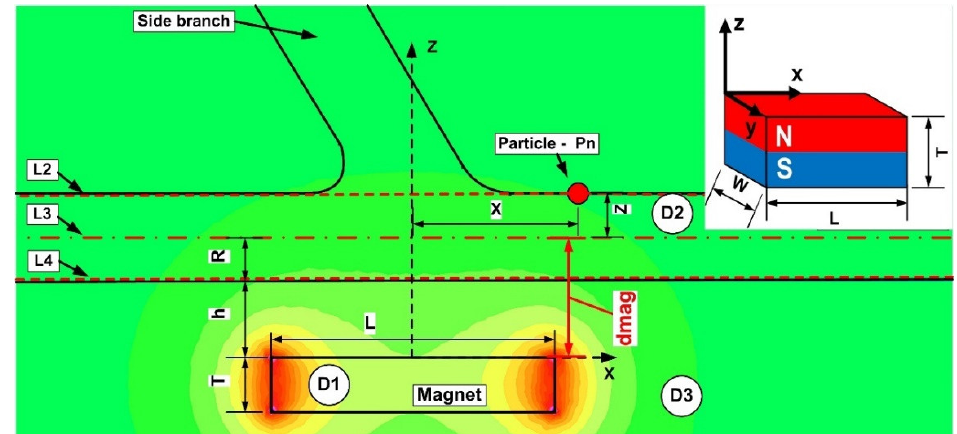
Figure 8. Definition of the investigation sections during numerical analysis. L1, L2, and L3 (dashed lines) depict the site of investigation of the magnetic field strength H. Figure shows the magnitude of the magnetic field generated produced by the ferrite-type magnet. The magnet is placed at h mm from the vessel’s bottom wall. This study employs three distinct domains: ( D1 )-permanent magnet; ( D2 )-carrier fluid; and ( D3 )-air.